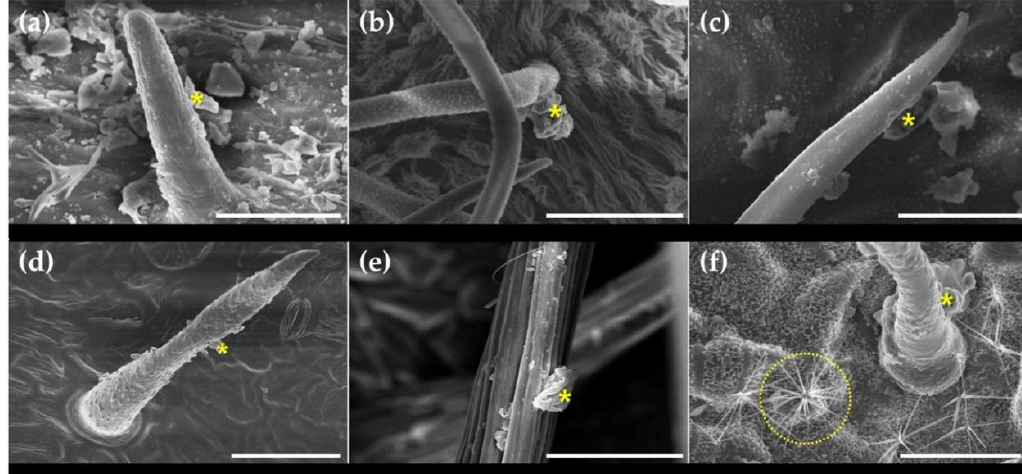
Figure 6. Representative scanning electron microscopy images showing various structural properties of trichomes and PM adsorption on leaf surfaces: ( a ) Buxus koreana (glandular trichome on the adaxial surface), ( b ) Aesculus turbinata (non-glandular trichome on the abaxial surface), ( c ) Magnolia denudata (non-glandular trichome on the abaxial surface), ( d ) Chionanthus retusus (peltate glandular and non-glandular trichome on the abaxial surface), ( e ) Rhododendron schlippenbachii (non-glandular trichome on the abaxial surface), and ( f ) Styphnolobium japonicum (stellate and non-glandular trichomes on the adaxial surface). Note: Yellow asterisk and dotted circle indicate PM particles of different size fractions and stellate trichome, respectively. Scale bars: ( a,c,f ) 30 μm; ( b,d,e ) 50 μm.